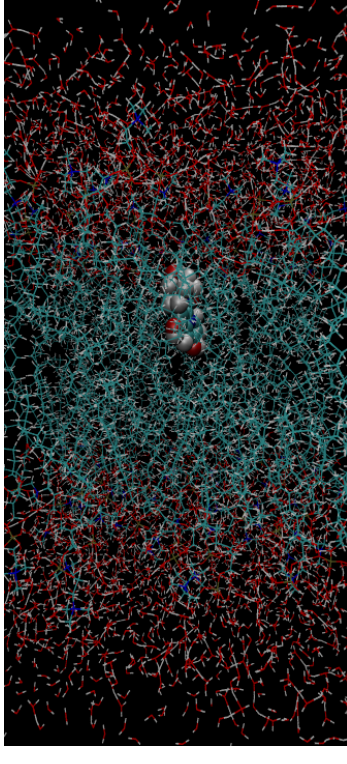
Figure 5. Molecule 2c within a bilayer system for the QM/MM calculation, showing the orientation of the